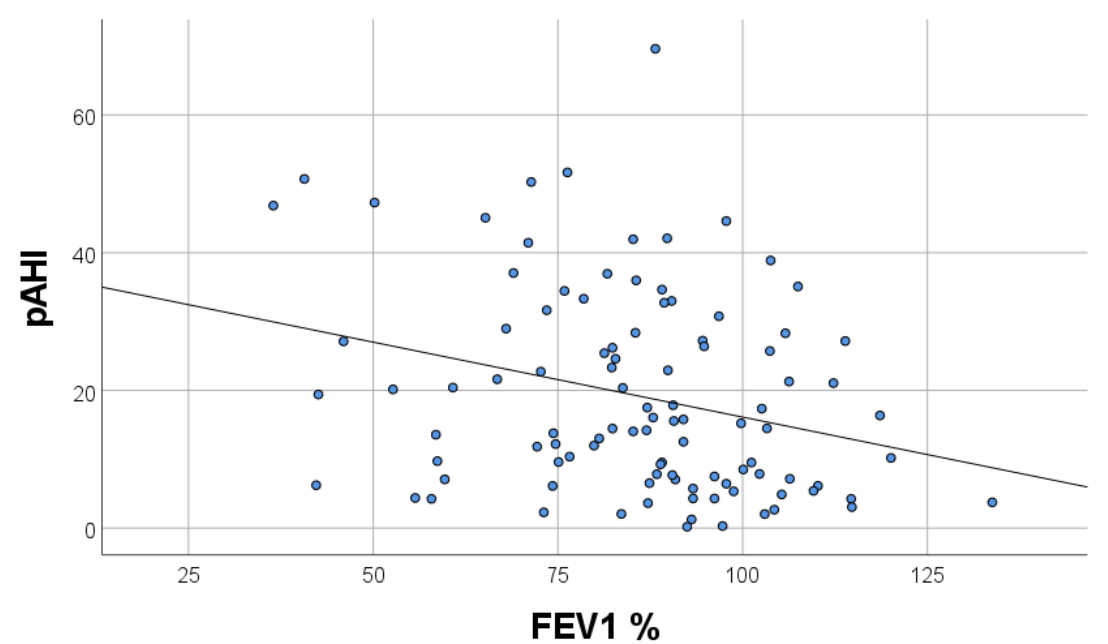
Figure 2. Correlation of peripheral artery tone acquired apnea/hypopnea index (pAHI) and reactive hyperemia index (RHI) values R= −0.387; p < 0.001.